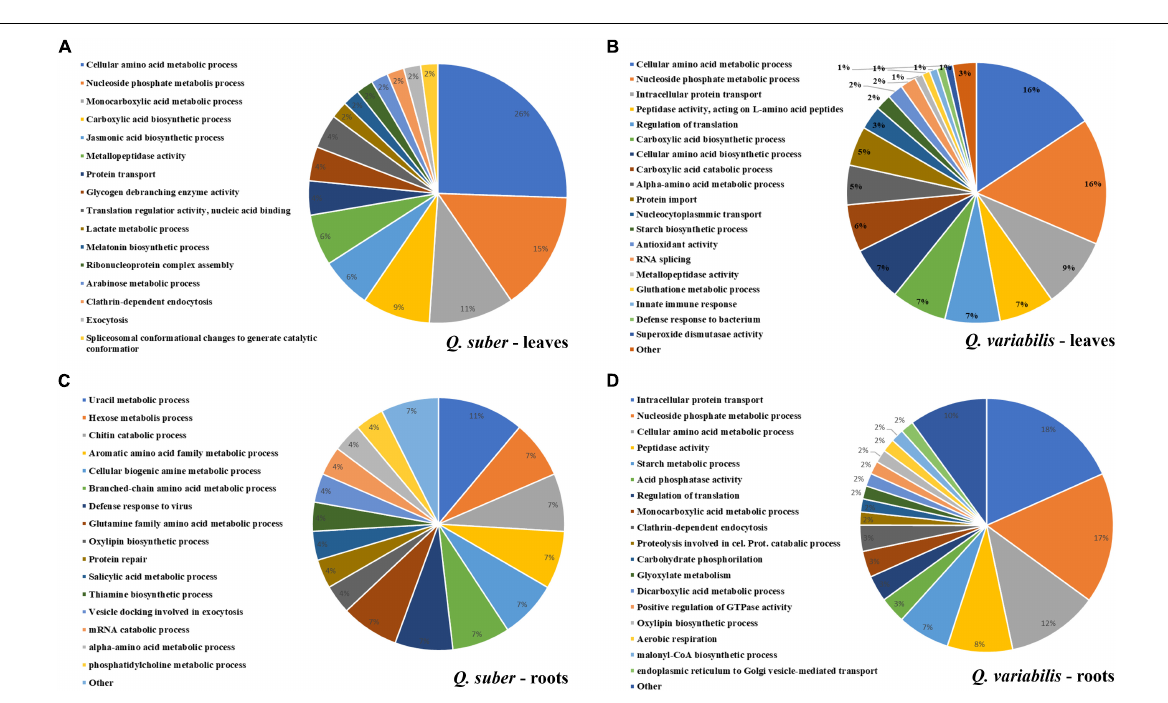
FIGURE 4 | Functional annotation enrichment of proteins that were affected in the leaves (A,B) and roots (C,D) of Q. suber (A,C) and Q. variabilis (B,D) between 4 and 16 h after inoculation with P. cinnamomi . Pie charts depict functional categories assigned by the Cytoscape ClueGO plug-in using Arabidopsis orthologs of Q. suber